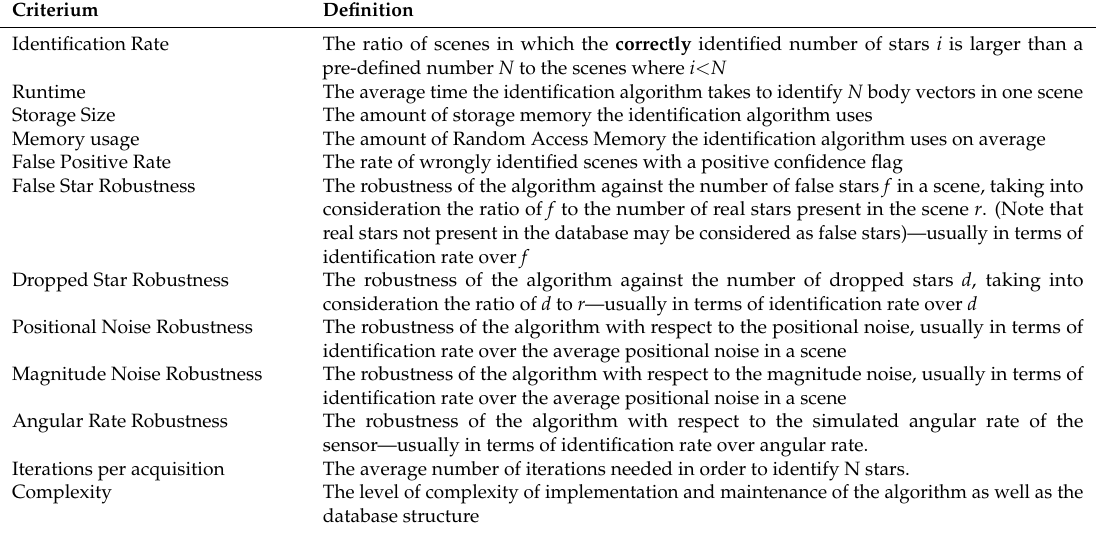
Table 2. Scoring criteria star identification